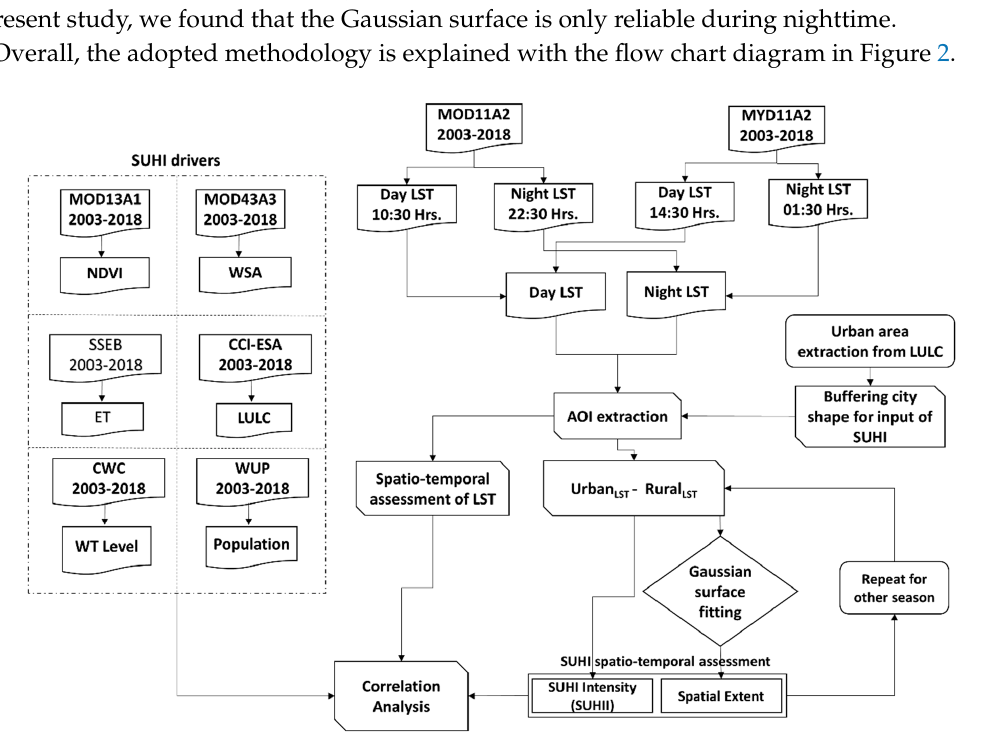
Figure 2. Flowchart for examining the surface urban heat island intensity (SUHII) and their potential drivers. LST, Land Surface Temperature; NDVI, Normalized Difference Vegetation Index; WSA, White Sky Albedo; SSEBop, operational Simplified Surface Energy Balance model; ET, Evapotranspiration; ESA, European Science Agency; LULC, Land Use/Land Cover; CWC, Central Water Commission; GW, Ground Water; WUP, World Urbanization Prospects.